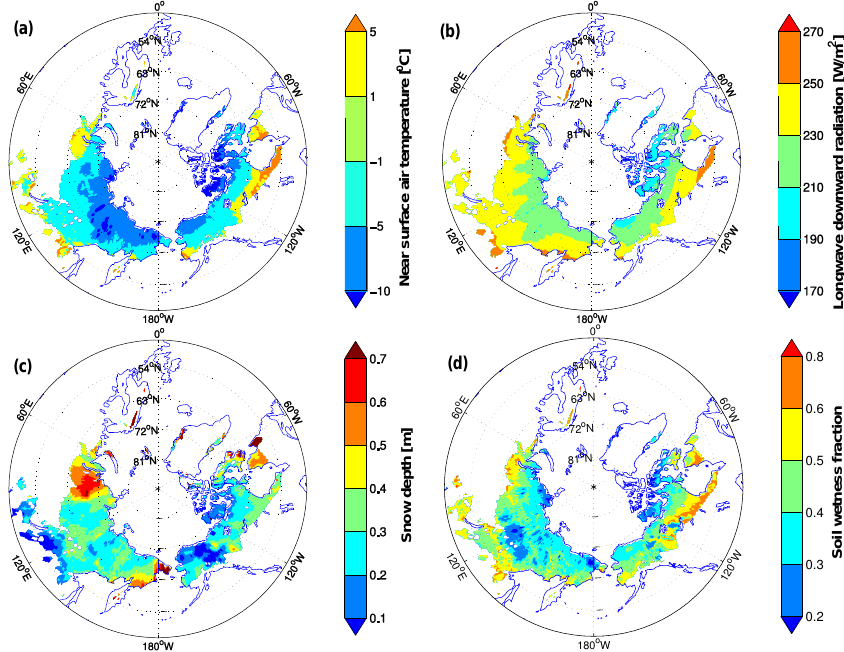
Figure 7. (a) The near-surface air temperature averaged over the first 2 months of the fall season. (b) The downwelling long-wave radiation, averaged yearly over 10 years. (c) The maximum snow depth obtained over 10 years for the steady-state run, and (d) the soil wetness fraction (dimensionless fraction of 1), representing overall near-surface soil wetness, averaged yearly over 10